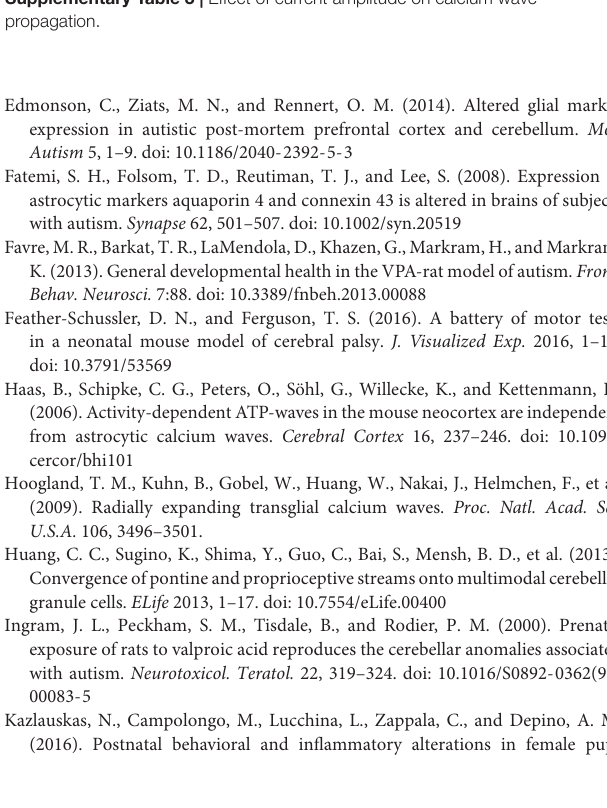
Supplementary Table 2 | Recruitment of SRB + cells. Supplementary Table 3 | Effect of current amplitude on calcium wave